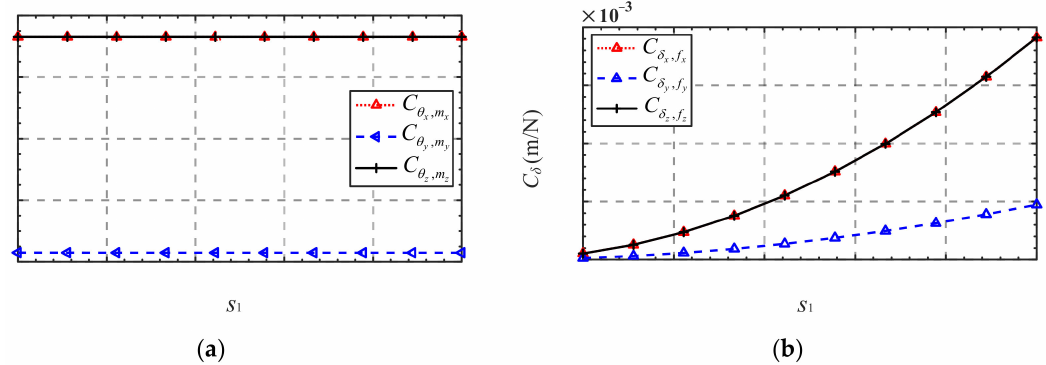
Figure 6. Compliance variation in terms of the scale coefficient s 1 : ( a ) C θ ; ( b ) C δ .